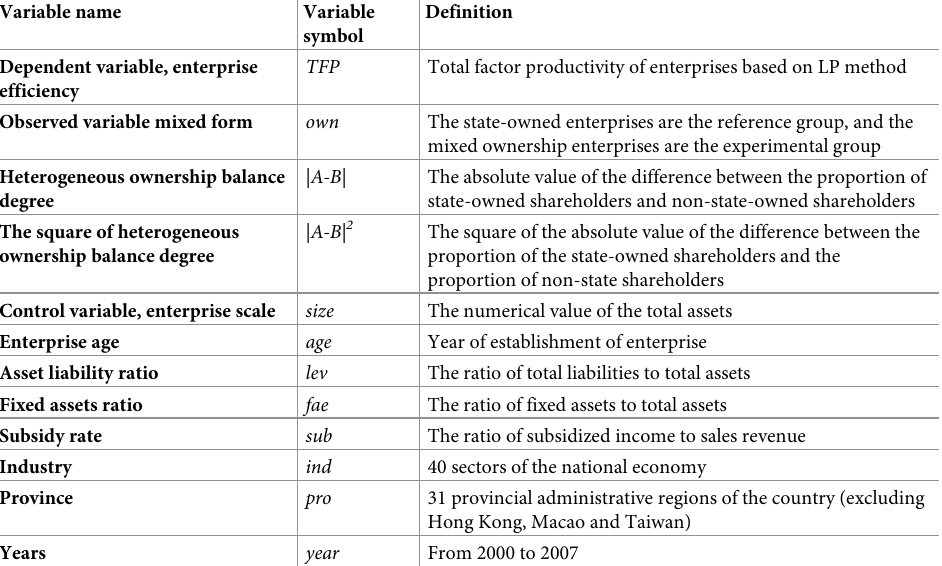
Table 1. Description of